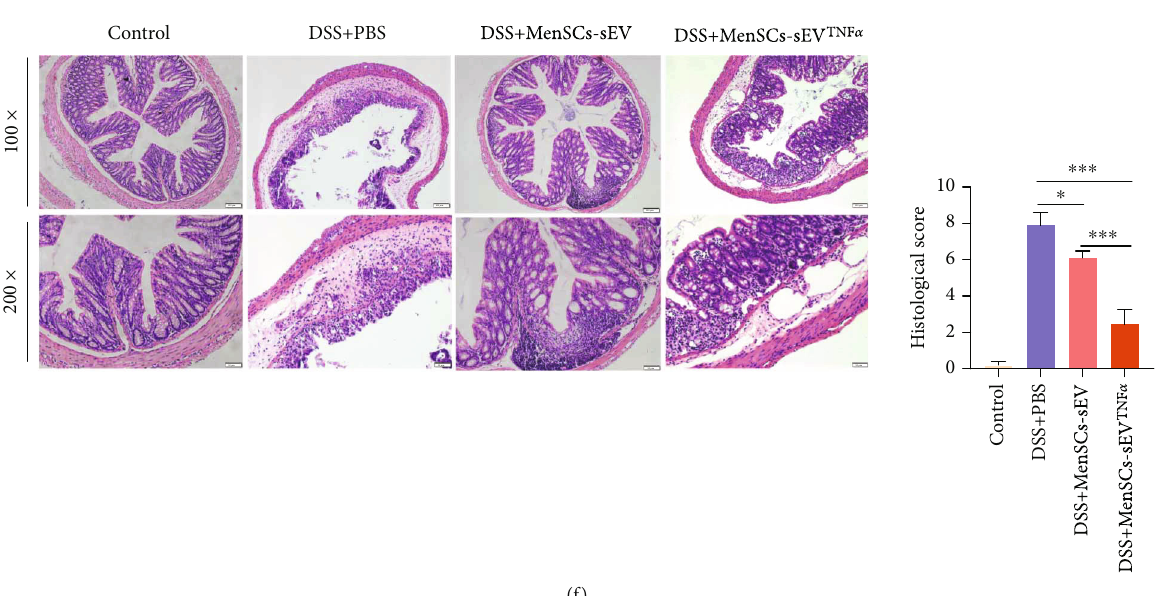
Figure 2: TNF- α -pretreated MenSC-derived small EVs can relieve colonic in fl ammation induced by DSS. Male wild-type C57BL/6 mice aged 6-8 weeks were given 5% DSS for one week and intraperitoneally injected with MenSCs-sEV and MenSCs-sEV TNF- α (200 μ g/mouse) ( n = 6 ) on day 2. (a, b) DAI scores and the weight of the mice were recorded daily. (c) Neutrophil in fi ltration in the colon can be measured with the MPO activity detection kit. (d, e) On day 8, after the mice were euthanized, colon length data and gross colon images were obtained. (f) After soaking in 4% paraformaldehyde for 48 hours, the colon was dehydrated and stained with hematoxylin and eosin. Original magni fi cation: × 100 (up) and × 200